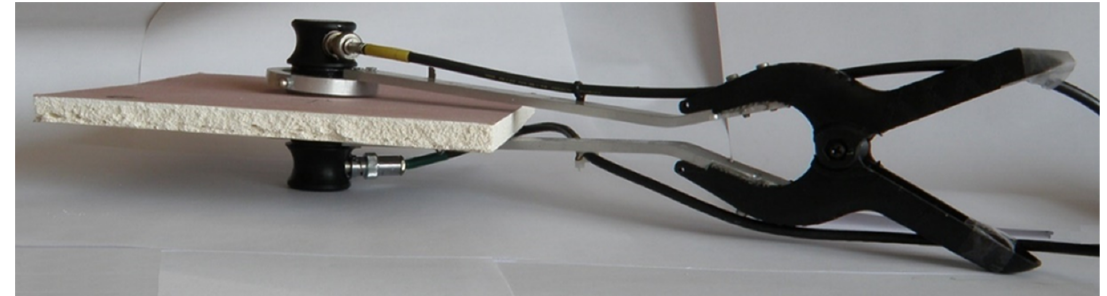
Figure 3. Detailed view of the custom designed holder for correct coupling between the ultrasonic transducers and both sides of the plasterboard specimen.